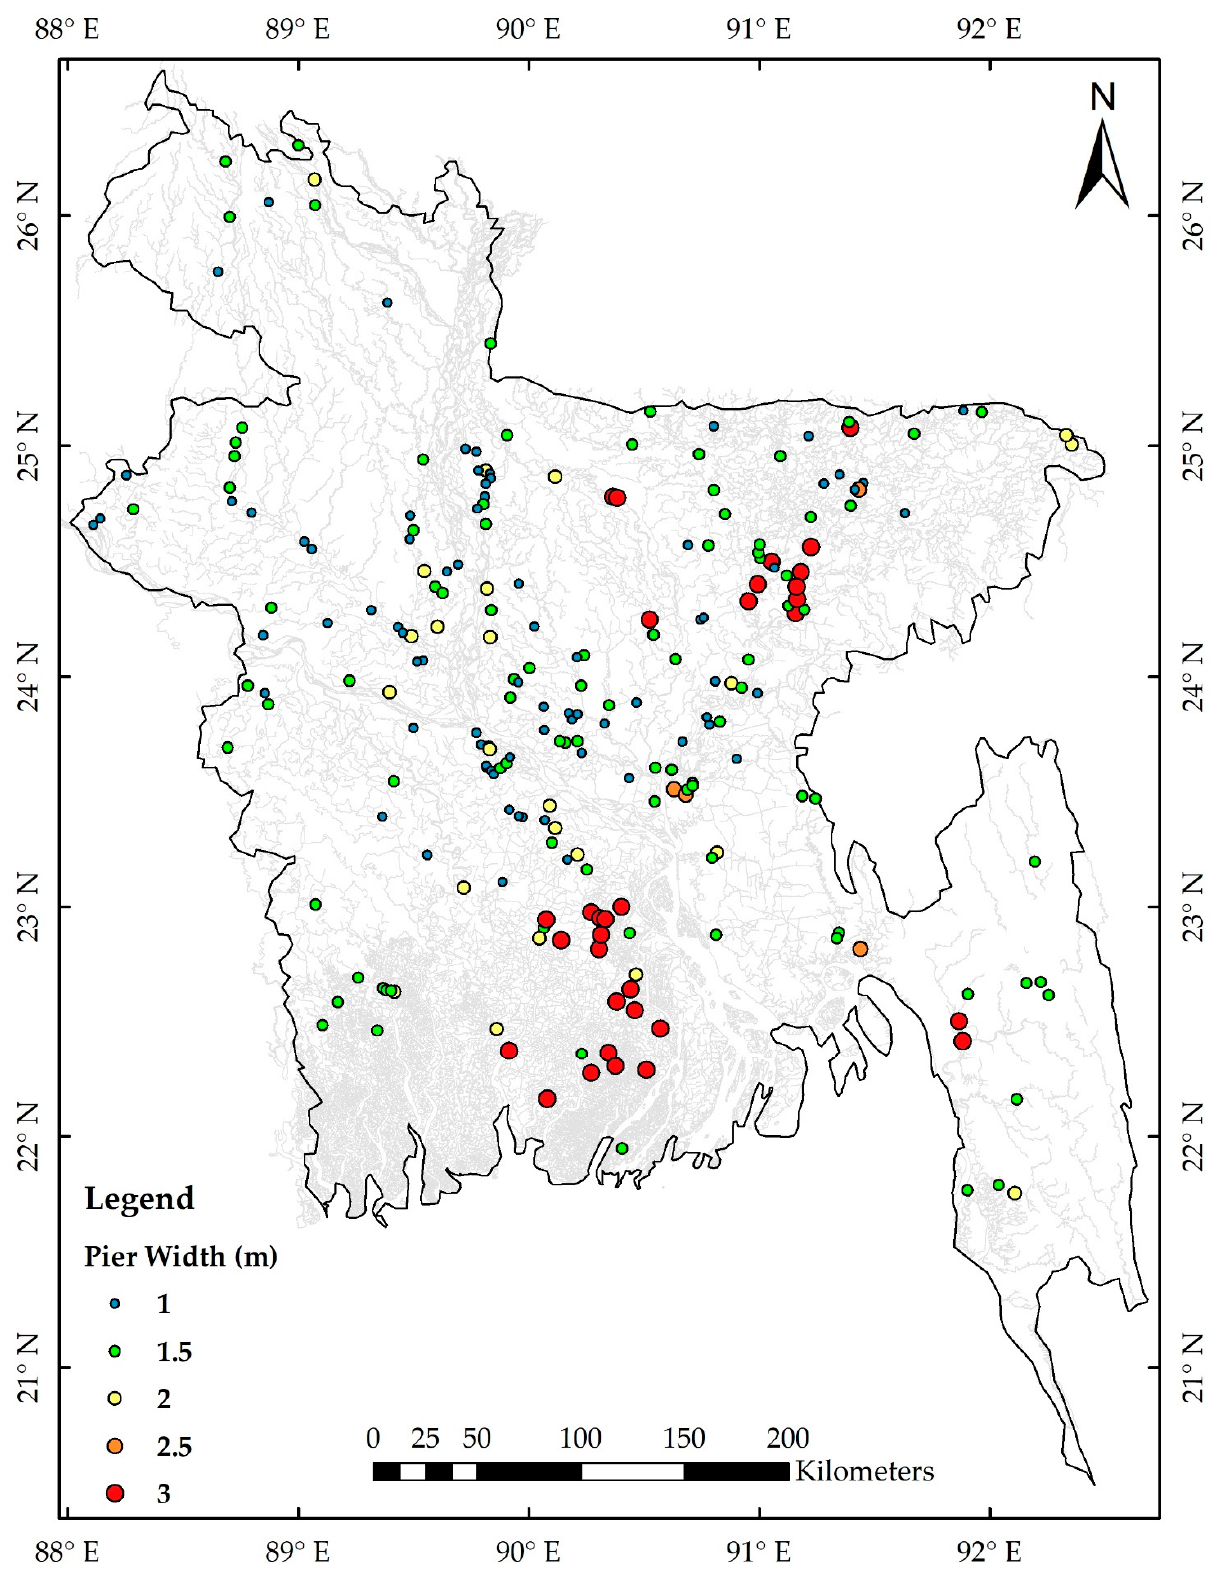
Figure 4. Variation of the pier widths of the study bridges over the Bangladesh rivers.